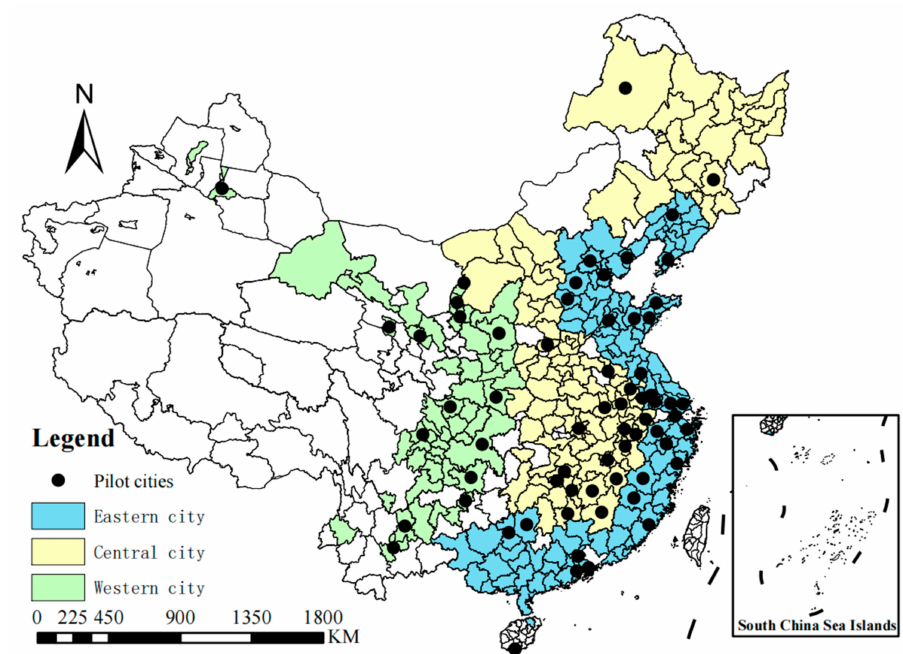
Figure 2. Distribution of low-carbon pilot